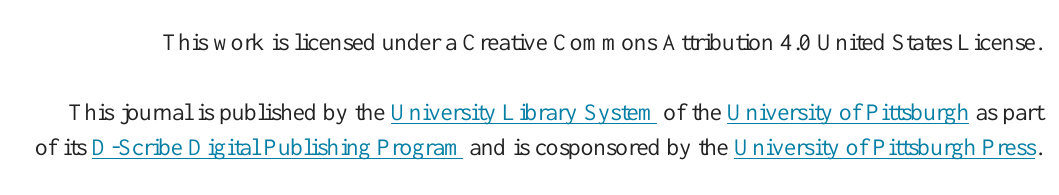
Table 2. The trends in the mortality rate across the top leading causes of child mortality by